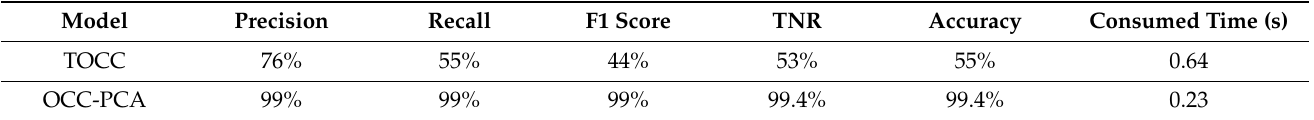
Figure 5. The Confusion Matrix of Both Models: ( a ) Description TOCC Confusion Matrix; ( b ) De- scription OCC-PCA Confusion Matrix. Table 5. OCC-PCA and TOCC Models Result in